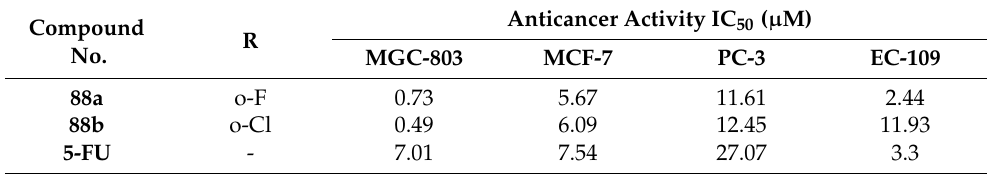
Table 74. In vitro cytotoxic activities of triazole-dithiocarbamate hybrid compounds 88 ( a – c ).